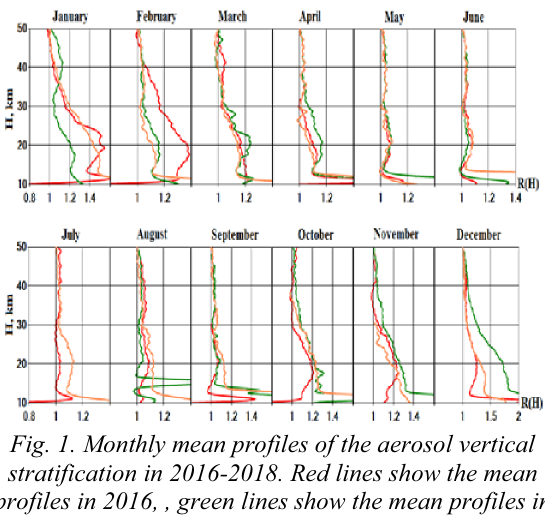
Fig. 1. Monthly mean profiles of the aerosol vertical stratification in 2016-2018. Red lines show the mean profiles in 2016, , green lines show the mean profiles in 2017, orange lines show the mean profiles in 2018.